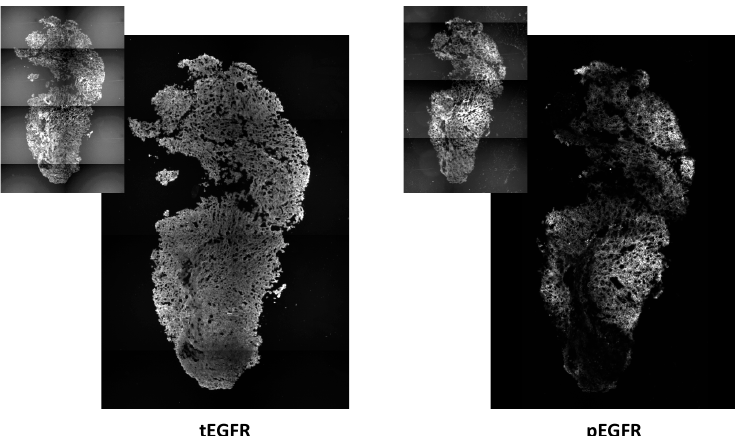
Figure 4. Epidermal growth factor receptor (EGFR) expression and activation is detected in tumor nodules with an incomplete response to intrathoracic PDT. Levels of total EGFR (tEGFR) and phosphorylated EGFR (pEGFR) were identified by immunohistochemistry. Insets depict fluorescence of red fluorescence protein (RFP) that identifies tumor cells. Disease was identified by bioluminescence imaging after intrathoracic PDT (treatment at 150 mW/cm, 1 mg/kg HPPH). Images represent an area of 1.7 mm × 2.6 mm (photographed at 10× magnification).